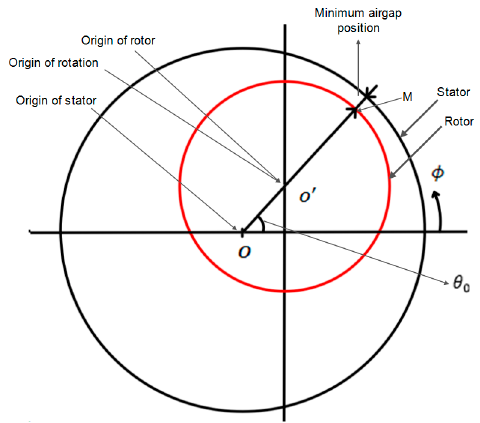
Figure 2. Motor geometry with static eccentricity.